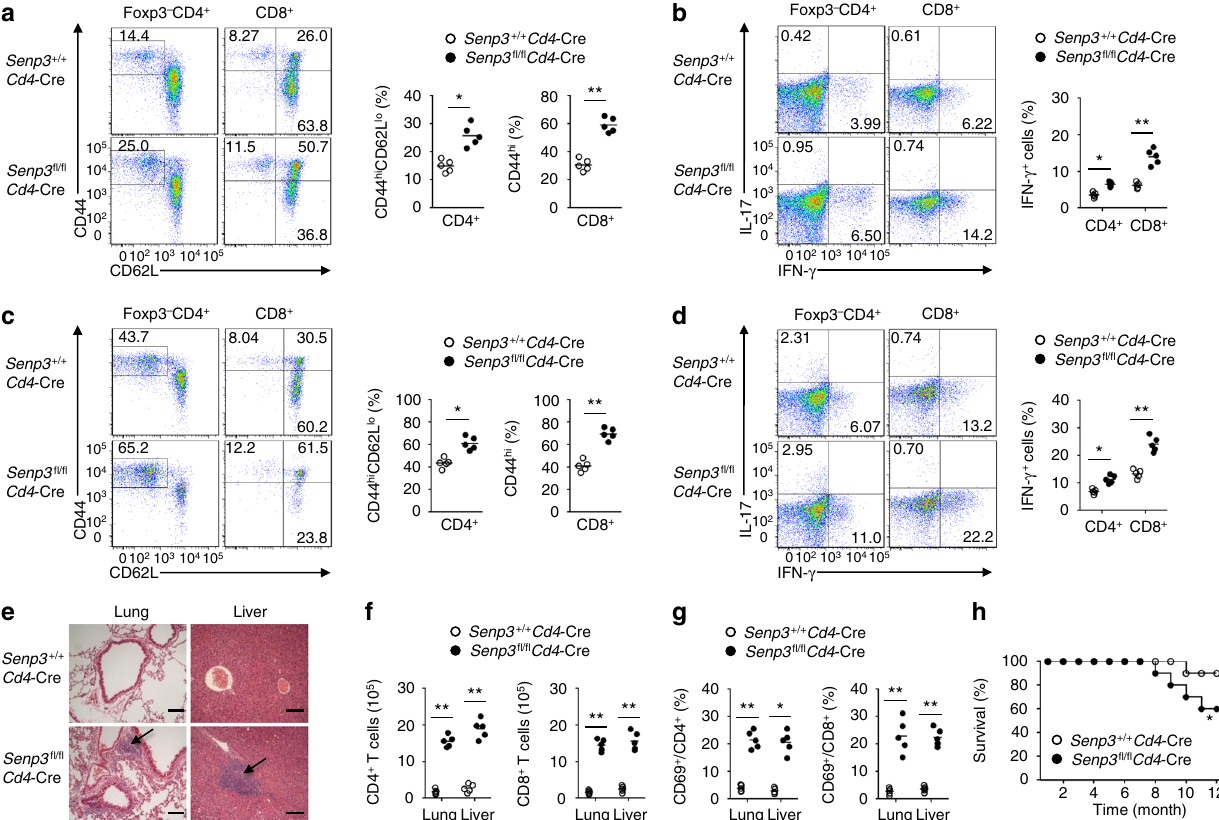
Fig. 1 T cell-speci fi c deletion of Senp3 perturbs T cell homeostasis. a Flow cytometric analysis of the frequency of naive (CD44 lo CD62L hi ) and memory-like (CD44 hi CD62L lo for CD4 + and CD44 hi for CD8 + T cells) CD4 + and CD8 + T cells in total splenocytes from 8-week-old Senp3 + / + Cd4 -Cre and Senp3 fl / fl Cd4 -Cre mice. b Flow cytometric analysis of the percentage of IFN- γ -producing and IL-17-producing CD4 + and CD8 + T cells in the spleen of 8-week-old Senp3 + / + Cd4 -Cre and Senp3 fl / fl Cd4 -Cre mice. c , d Flow cytometric analysis of the frequency of naive and memory-like ( c ) or IFN- γ -producing and IL-17- producing ( d ) T cells in total splenocytes from 8-month-old Senp3 + / + Cd4 -Cre and Senp3 fl / fl Cd4 -Cre mice. e Hematoxylin-eosin staining of the indicated tissue sections from 8-month-old Senp3 + / + Cd4 -Cre and Senp3 fl / fl Cd4 -Cre mice, showing immune cell in fi ltrations into the Senp3 fl / fl Cd4 -Cre tissues (arrows). Bars, 100 μ m. f , g Quanti fi cation of CD4 + and CD8 + T cells ( f ) and percentage of CD4 + and CD8 + T cells expressing CD69 ( g ) in the lungs and livers of 8-month-old Senp3 + / + Cd4 -Cre and Senp3 fl / fl Cd4 -Cre mice. h Survival curves of Senp3 + / + Cd4 -Cre and Senp3 fl / fl Cd4 -Cre mice ( n = 10). Data are representative of three or more independent experiments. Error bars are the mean ± SEM values. n = 5 or 10. Two-tailed unpaired Student ’ s t tests were performed. * P < 0.05; ** P <